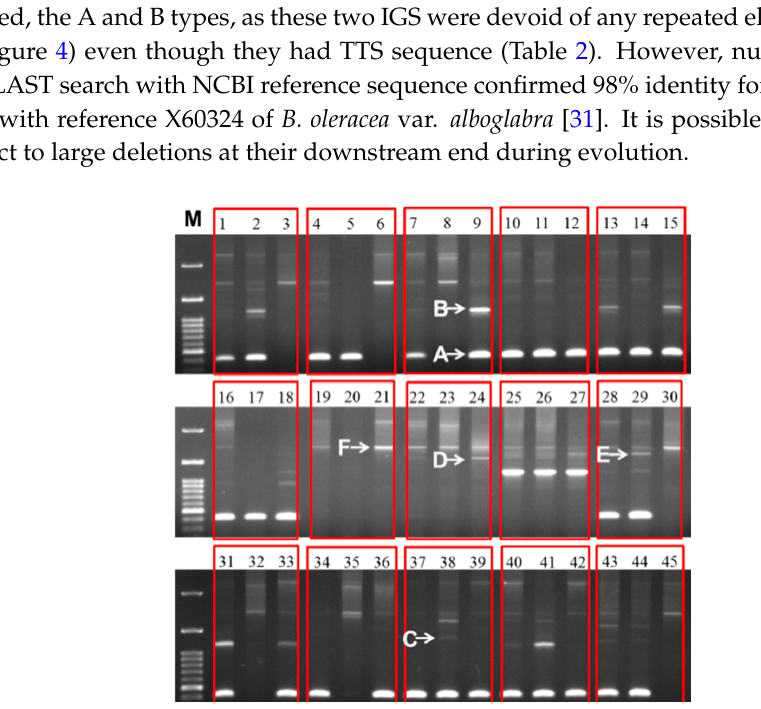
Figure 5. Different sizes of 45S (25S-18S) IGS sequences observed in 30 inbred lines of cabbage and their 15 F 1 progeny. The line numbers correspond to those in Table 3C. Within each red box the first, second, and third lanes represent F 1 , female parent, and male parent, respectively. M, 100 bp ladder. Sequences of IGS regions are also difficult to elucidate because as one individual cell may retain more than one type of IGS (Figures 2 and 5). Tremousaygue et al. [31] published an updated sequence of the IGS region of B. oleracea var. alboglabra after Bennett and Smith [30] which is 206 bp longer. That variation is explained by the different digestion sites of EcoR1 used by [31] and BamH1